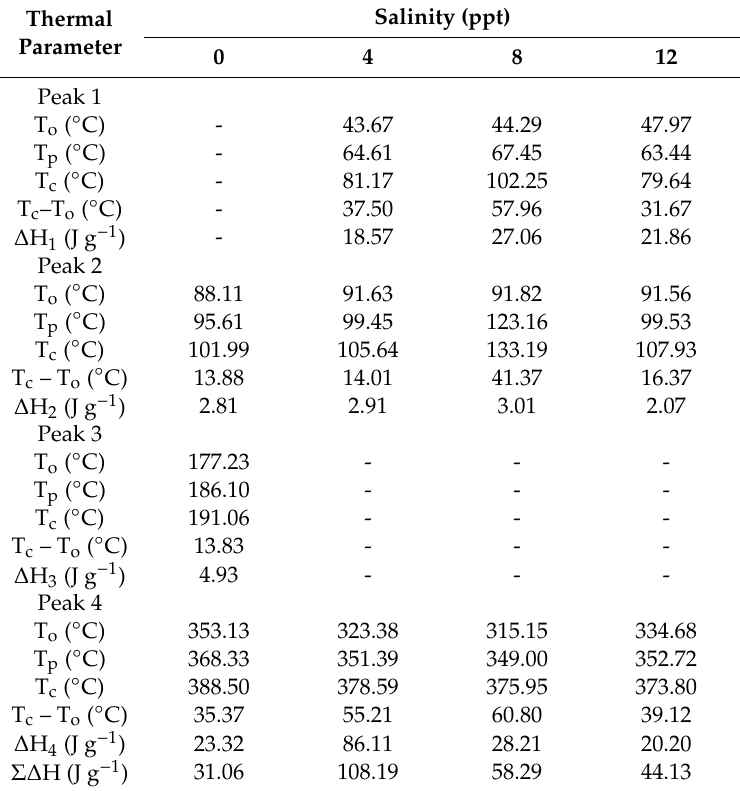
Table 2. The thermal transition characteristics of feces of northern river terrapin reared in various salinities. The sampling was done at the end of the 8-week